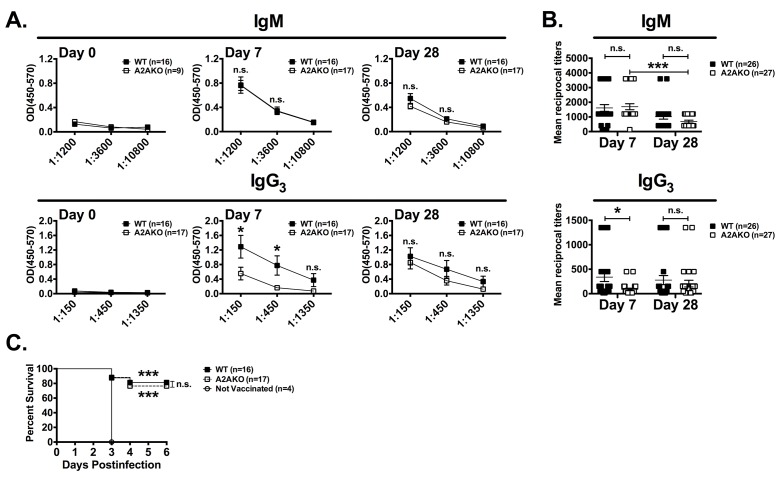
A2aR-deficiency is associated with delayed IgG3 response after Pneumovax 23 vaccination.8 to 12-week-old WT and A2a KO mice were immunized i.p. with Pneumovax 23 and sera were analyzed by ELISA for anti-PPS3 specific Abs on days 0, 7 and 28 after vaccination. On day 28, mice were challenged by i.p. injection of S. pneumoniae (105 CFU). (A) Anti-PPS3 IgM and IgG3 OD (450–570) readings are shown (means ± standard errors are shown; *: p<0.05; **: p<0.01 by Student’s T test). (B) Combined results from 2 experiments pooling 26 WT and 27 A2a KO mice showing IgM and IgG3 mean reciprocal titers at day 7 and 28 (means ± standard errors are shown; *: p<0.05; by One-way ANOVA; brackets are shown when significantly different from day 7 and 28 for a given group). (C) Survival of infected mice was monitored (*: p<0.05 by log-rank test; survival was compared to non-vaccinated mice, unless indicated by a bracket; n.s: not significant).